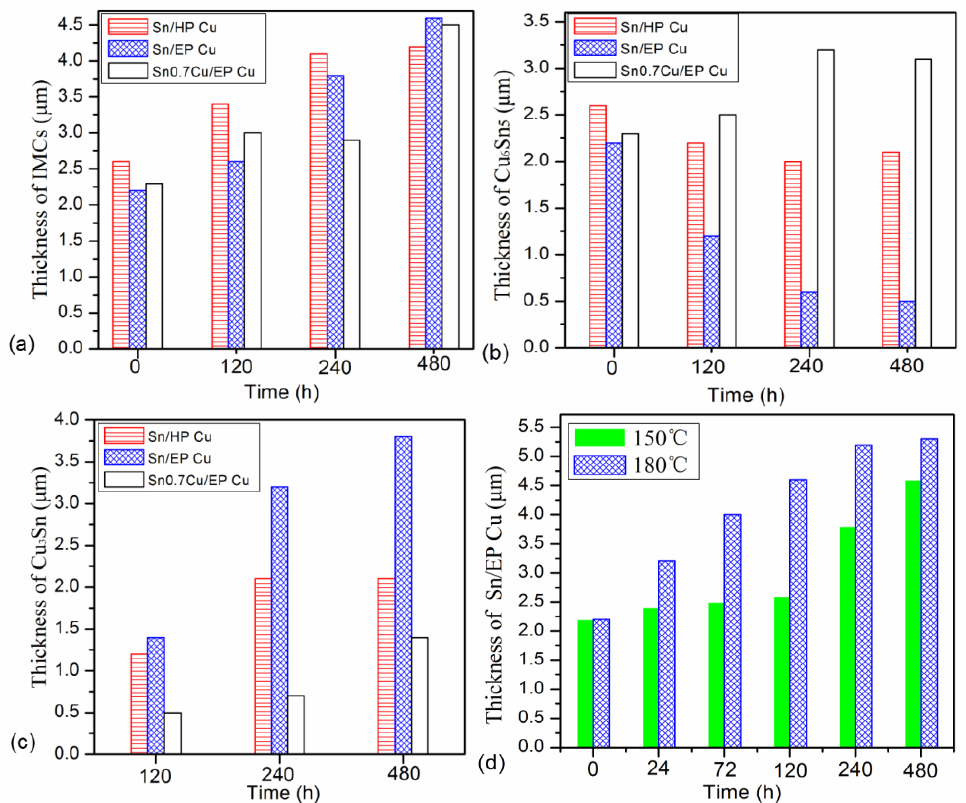
Figure 5. Relationship between aging time and average thickness of total IMCs ( a ), Cu 6 Sn 5 ( b ), and Cu 3 Sn ( c ) layer for the three kinds of solder joints after aging at 150 ◦ C and 180 ◦ C ( d ),